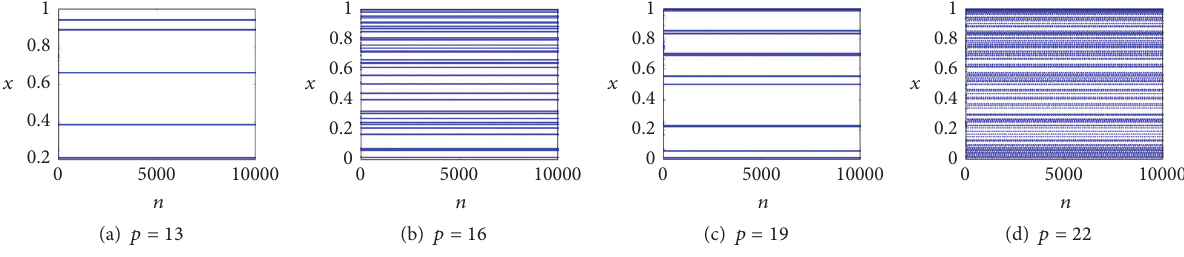
decided before from the bifurcation diagrams in Section